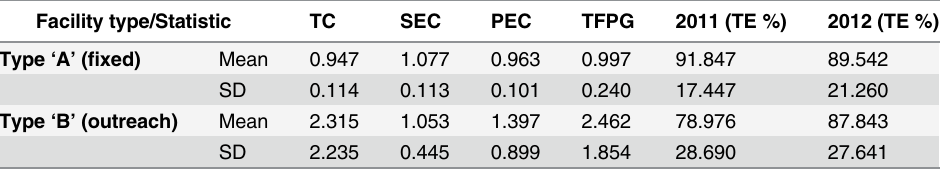
Table 8. Productivity indices for VMMC facilities by types between 2011 and